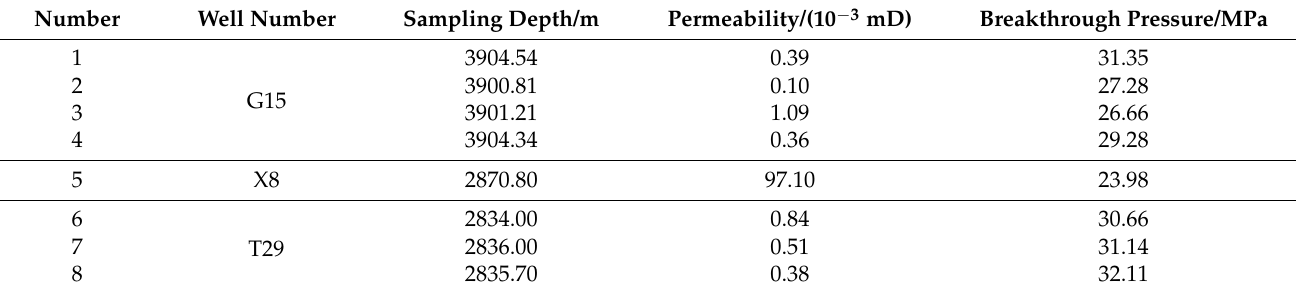
Table 11. Breakthrough pressure of caprock sample of adjacent well in X9 area (confining pressure 60 MPa, temperature 70 ◦